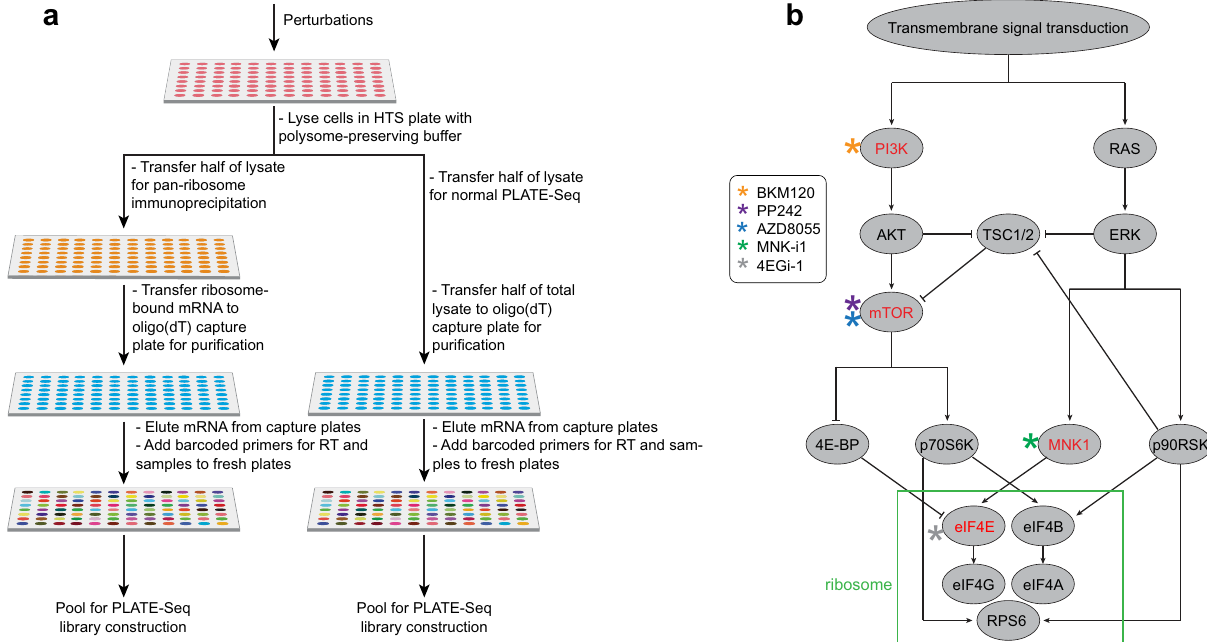
Figure 1. Overviews of the protocol and experimental design of the study performed. ( a ) Schematic diagram of the riboPLATE-seq protocol, from lysis in a multi-well plate to pooled library preparation. The right-hand side mirrors the original PLATE-seq protocol. In this workflow, an oligo(dT)-grafted plate captures polyadenylated RNA that can be reverse-transcribed with barcoded adapters, generating a plate of cDNA that may be pooled for library construction. The left side incorporates a pan-ribosome IP before PLATE-seq pooling and library preparation, generating instead a pooled library of ribosome-associated RNA. ( b ) Simplified structure of the signaling pathways under study and the specific protein targets considered. The PI3K/AKT/mTOR signaling axis at left converges with the MAPK/ERK pathway at right on eIF4E, early in the process of ribosome assembly (green box). The figure also outlines the inhibitors used in this study and their specific targets within these pathways. NVP-BKM120 is a PI3K inhibitor (orange), both AZD8055 and PP242 are mTOR inhibitors (blue and purple, respectively), MNK-i1 is a MNK1 inhibitor (green), and 4EGi-1 is a direct eIF4E inhibitor